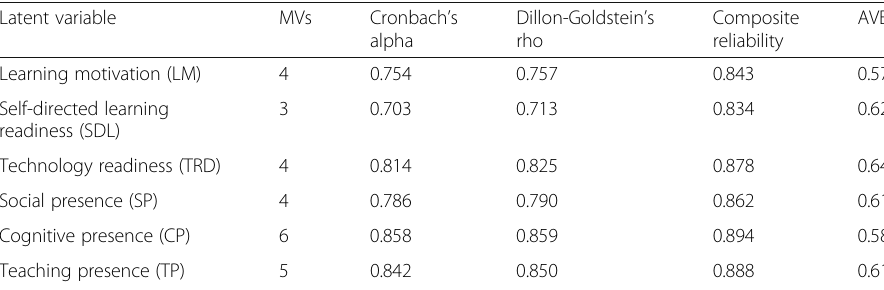
Table 1 Unidimensionality of